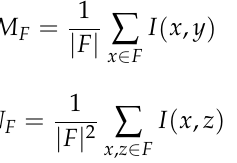
Algorithm 1. MRMR Algorithm—Pseudocode for optimal features selection